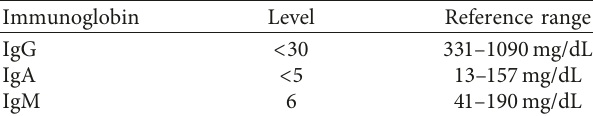
Figure 1: Small 3 × 5mm vegetation on atrial aspect of the mitral valve as visualized on echocardiogram Apical four chamber view with apex up and posterior angulation. Table 1: Immune workup showed the following labs.